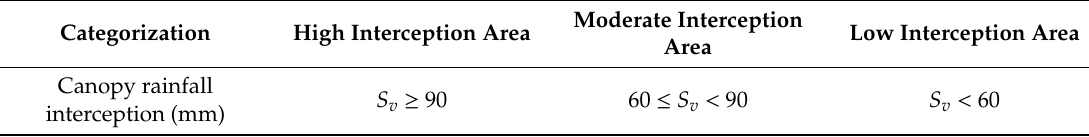
Table 1. Categorization of canopy rainfall